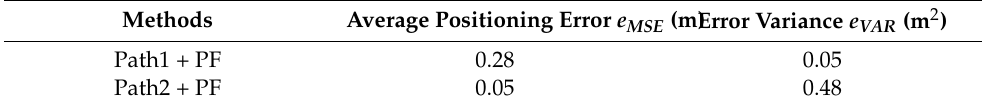
Table 7. The localization effects of using MEPO method and particle filter (MEPO-PF).